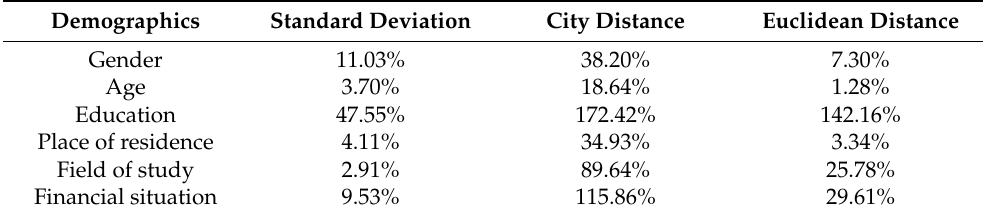
Table 1. Indicators of differences between the demographic criteria (attributes) in Poland and Turkey in 2021; source: own